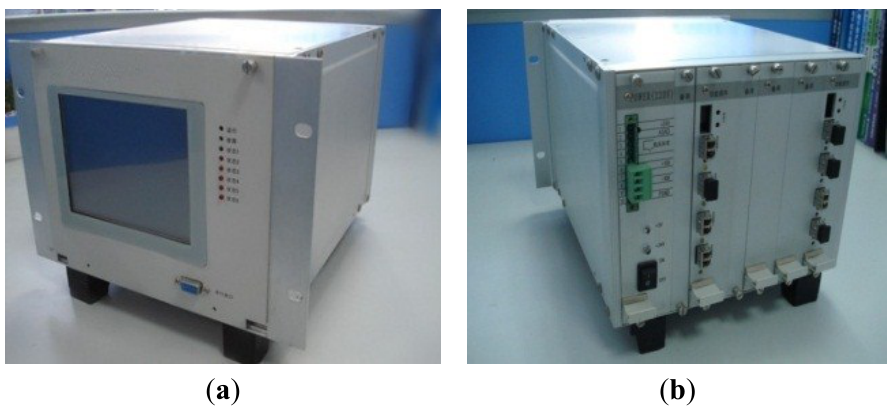
Figure A7. Photograph: ( a ) the front side and ( b ) the back side of ECP plus.